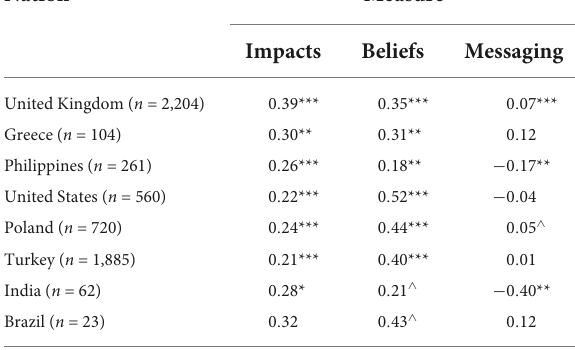
TABLE 9 Explaining culture-level variance: weighted correlations between culture-level socioecological variables and the relationships of age and biological sex with outcomes.